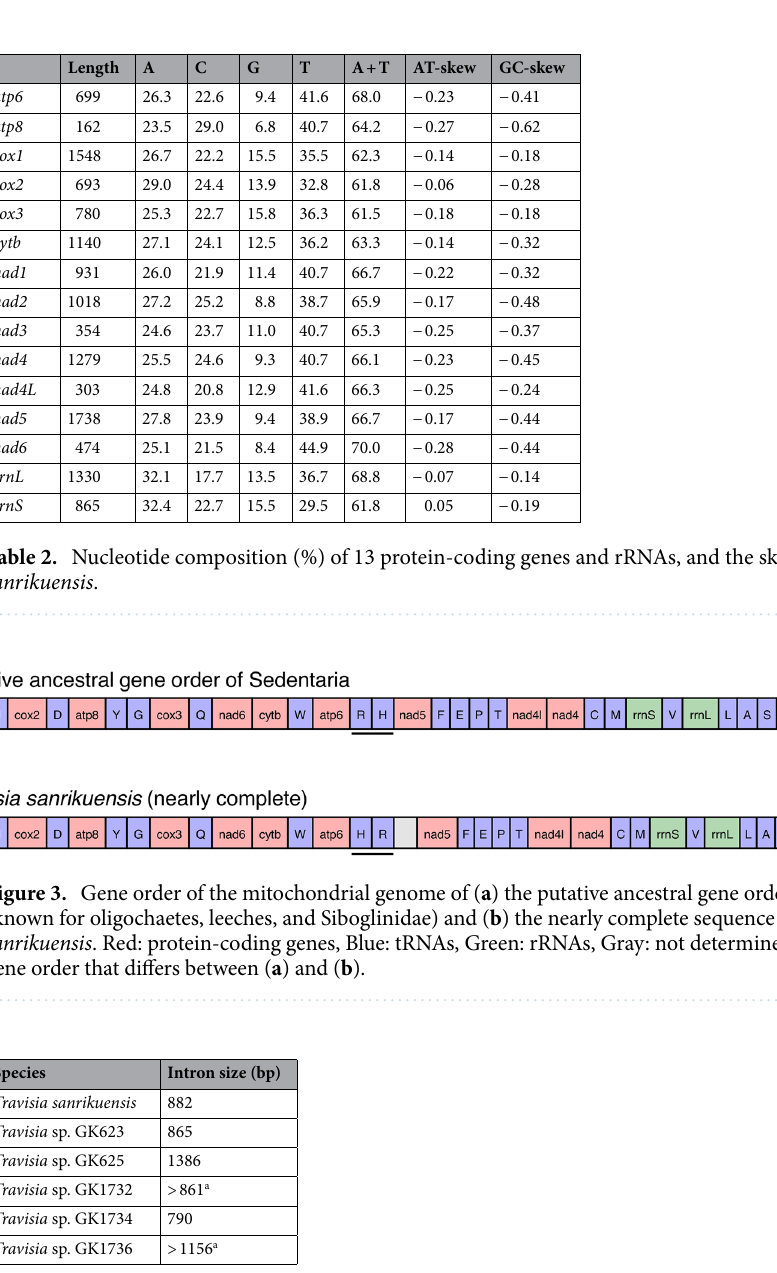
Table 3. Intron size of Travisia spp. a Partial nucleotide sequences were determined.